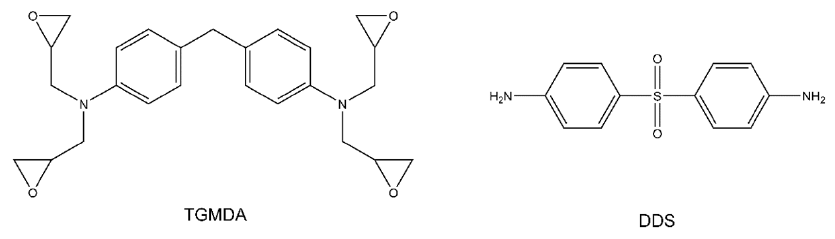
Figure 3. Molecular Structure of difunctional epoxy.